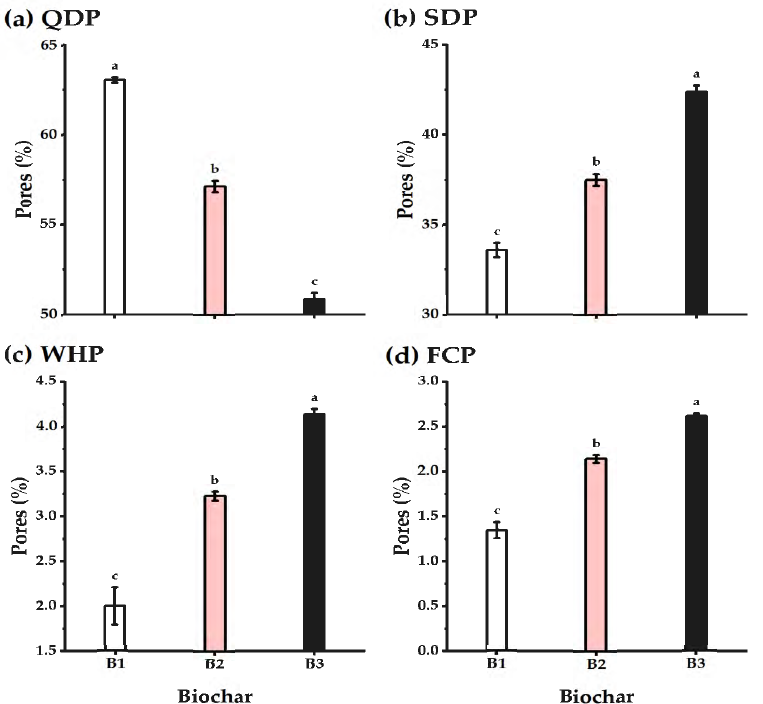
Figure 6. Effect of three levels of biochar soil supplementation (0 (B 1 ), 7.5 (B 2 ), and 15 t ha − 1 (B 3 )) on the physical properties of soil cultivated with wheat at the harvest stage in sandy soil. ( a ) Quickly drainable pores (QDP,%), ( b ) slowly drainable pores (SDP,%), ( c ) water holding pores (WHP,%), and ( d ) fine capillary pores (FCP,%). Bars and error bars represent the means ± SE, respectively, of three biological replicates. Different letters reveal statistically significant differences among